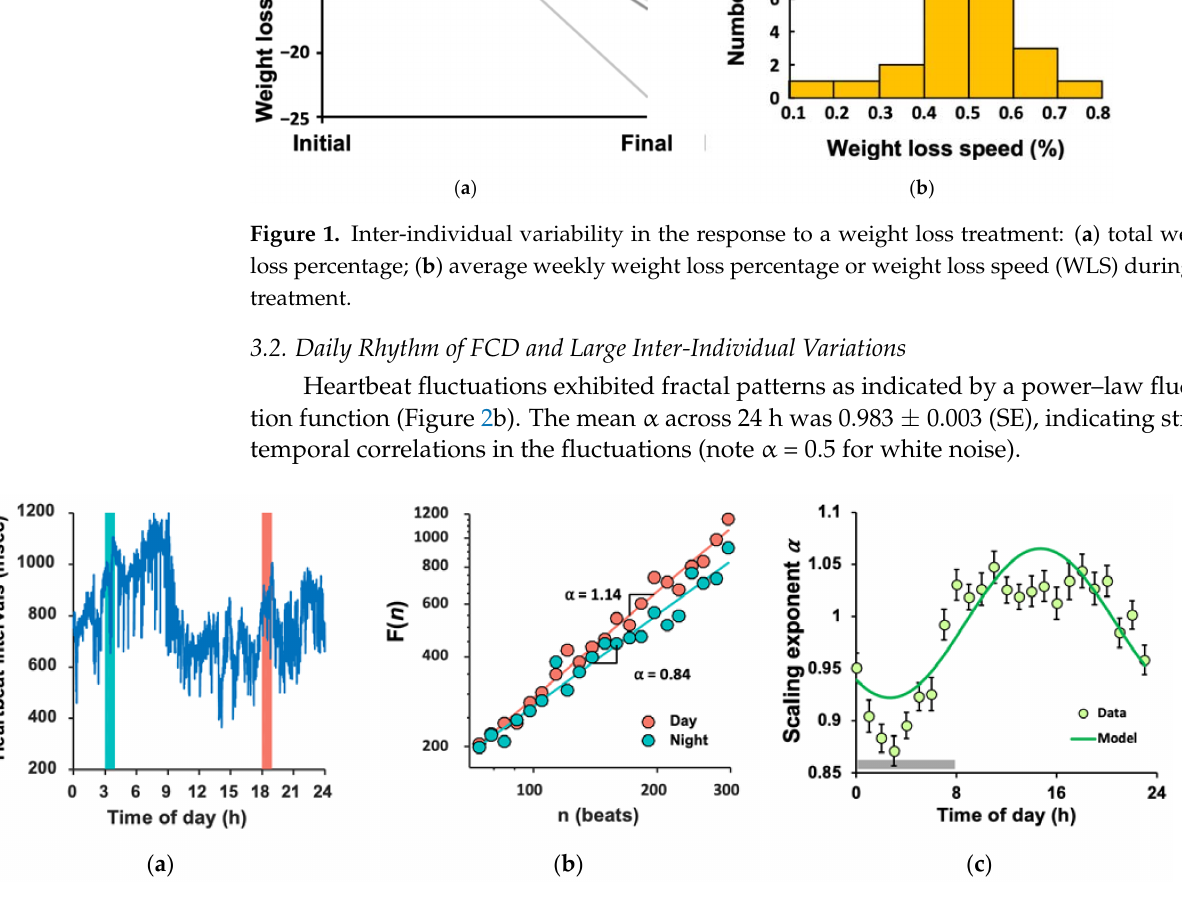
Figure 2. Daily rhythm of FCD: ( a ) A sample recording of 1-day heartbeat intervals. Data were collected from a 39-year-old woman not carrying CLOCK 3111 C allele. ( b ) Representative detrended fluctuation functions, F ( n ), of the two 1 h recordings marked in A (pink for the daytime; and cyan for the night-time). Data are shown on log–log plots. On the abscissa, n presents the time scale in heartbeats. The detrended fluctuation functions F ( n ) are vertically shifted for better visualization of the difference in the scaling exponent α (slope) between the daytime and night-time; ( c ) Mean daily rhythm of the scaling exponent α in all 39 subjects and the 24 h rhythm fitted by cosinor analysis. Error bars indicate standard error of the mean. The grey horizontal line indicates the average period of sleep for all